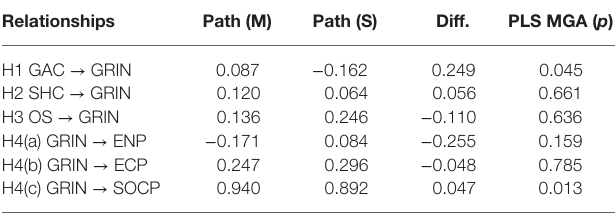
GRIN, green innovation; ENP, environmental performance; SOCP, social performance; ECP, economical performance. Bold font: PLS-MGA value of p below 5% and above 95% indicates significant values. Diff., path coefficient